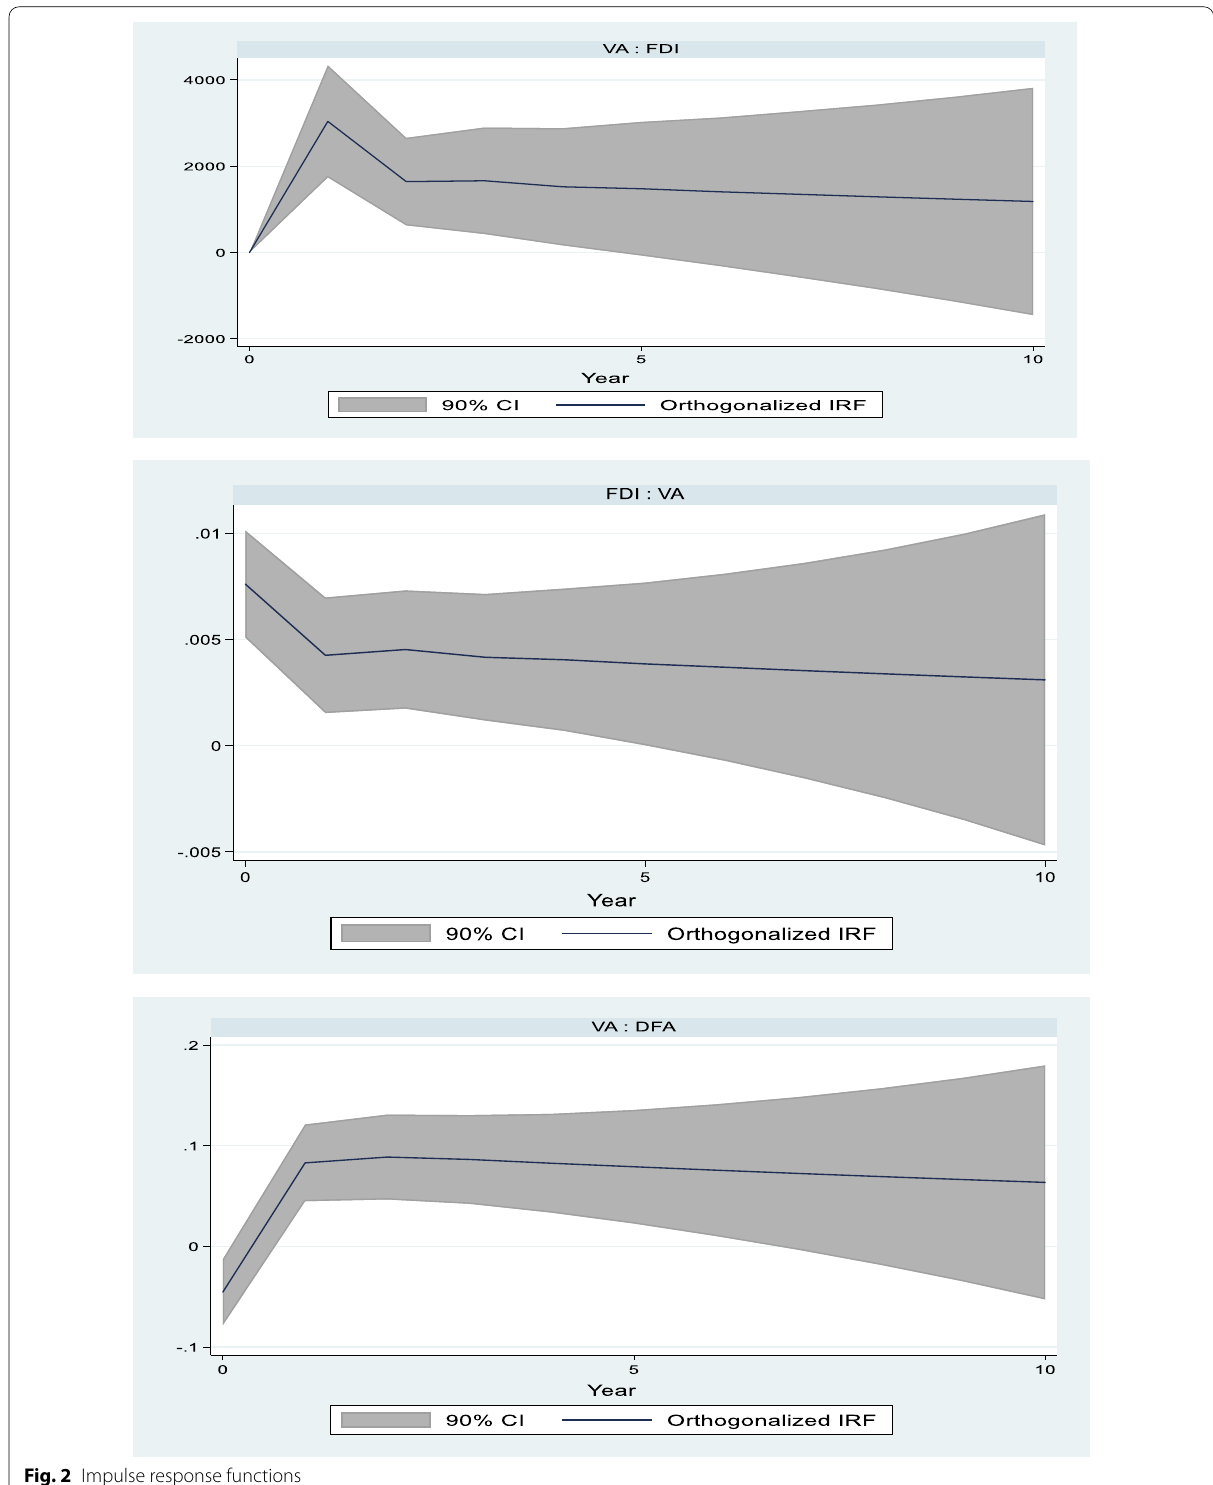
Fig. 2 Impulse response